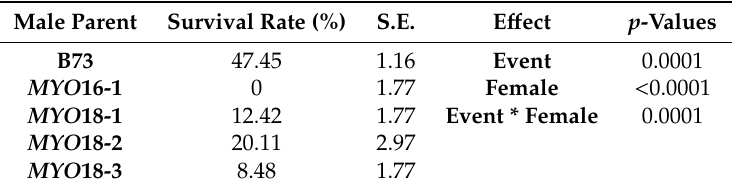
Table 3. Average offspring survival rate after herbicidal treatment, along with standard errors. Table 3. Average o ff spring survival rate after herbicidal treatment, along with standard errors. p -values p -values are also provided for transgenic events, female parent, and their interaction. are also provided for transgenic events, female parent, and their interaction. Male Parent Male Parent